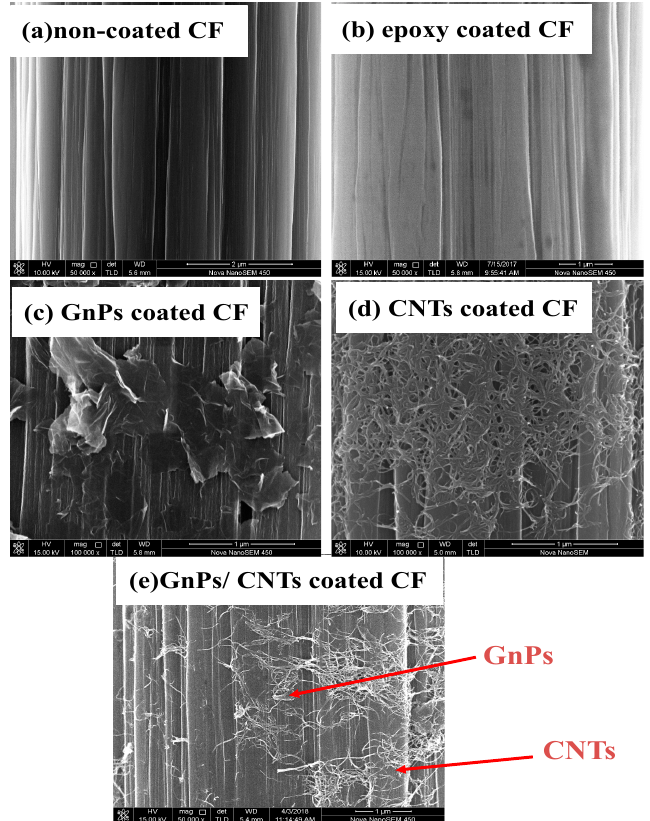
Figure 4. The surface morphology of CF: ( a ) non-coated CF, ( b ) epoxy coated CF, ( c ) GnPs coated CF, ( d ) CNTs coated CF and ( e ) GnPs/CNTs coated CF.